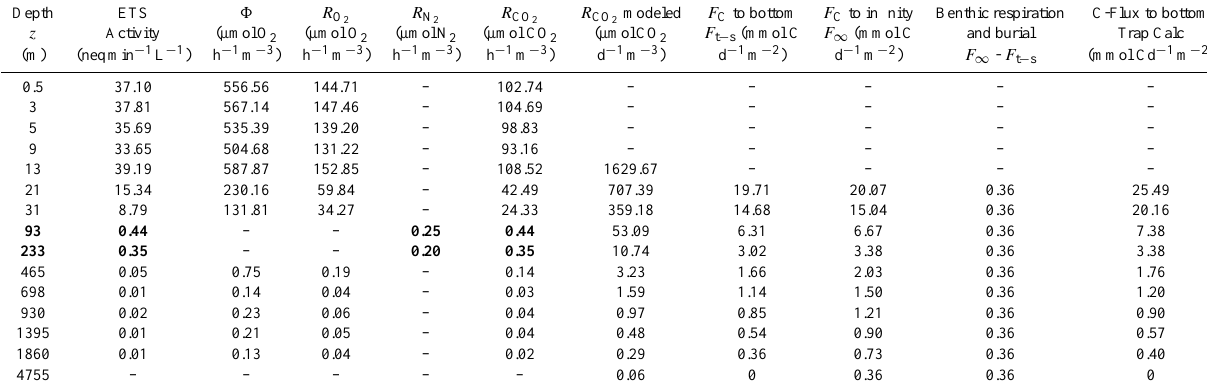
Table 3. R O as µmolO 2 h − 1 m − 3 profiles in the microplankton along the C-line section in September 1976 (roman font values). At the 2 OMZ depths (values in bold), NO − was the electron donor and N 2 was produced during denitrification ( R N 3 position as well as JASON station number (in parentheses) are given. Depth ( z ) is in meters and R refers to either R O the font. Calculations are explained in the